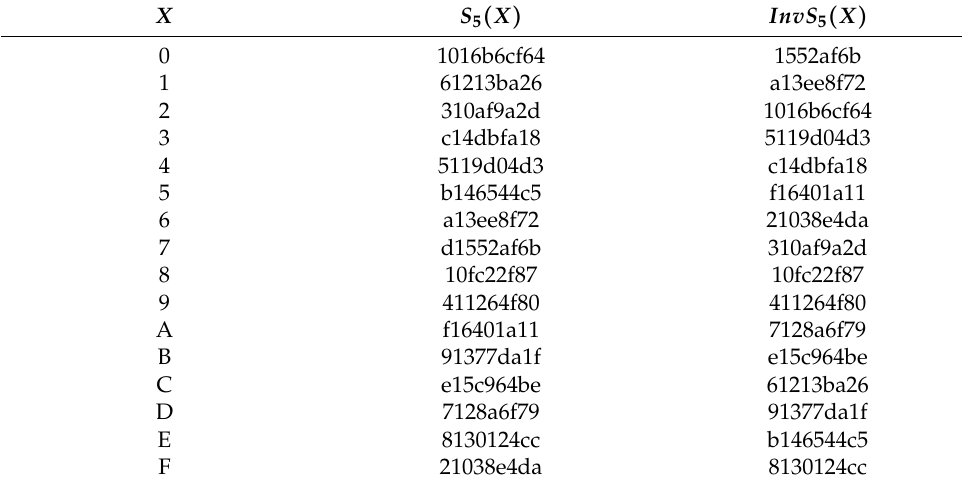
Table 15. New generated 32-bit output S-Box to replace Table